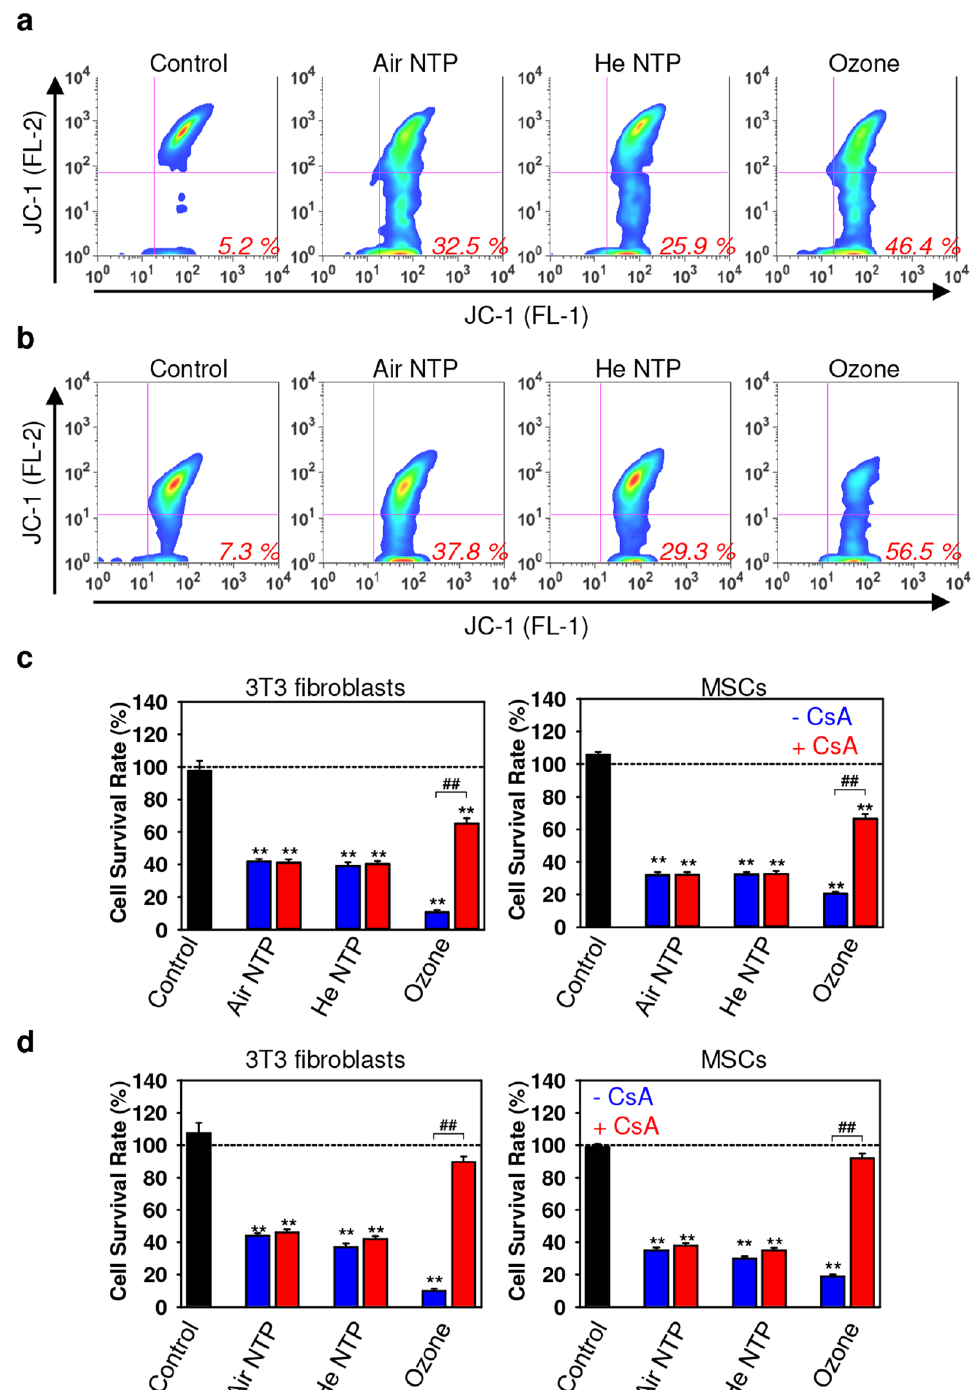
Figure 7. Ozone mediates CypD-related necrosis. Air, helium NTPs and ozone treatments induce mitochondrial dysfunction in 3T3 fibroblasts ( a ) and MSCs ( b ). Cells were stimulated with different NTPs and ozone then stained with 2 μ M JC-1 for 30 min, and analyzed by flow cytometry. Numbers show amounts of JC-1 cells with redlow fluorescence exhibiting damaged mitochondria. Representative flow charts out of three independent experiments are shown. ( c ) Cyclosporin A (CsA, an inhibitor of the mitochondrial permeability transition – mPT) antagonizes the ozone-induced cytotoxicity. Cell viability as detected by the WST-1 assay of 3T3 fibroblasts and MSCs treated with air, helium NTPs or ozone for 60 s with supplementation of 10 µ M CsA, measured 24 h after exposure. Readings were done in quadruplicates, data are present as mean ± SD, n = 4 (four independent experiments), * P < 0.05 ** P < 0.01. ( d ) Appropriate CsA dose completely eliminates ozone-induced cell death. Cell viability as detected by the WST-1 assay of 3T3 fibroblasts and MSCs treated with air, helium NTPs or ozone for 60 s with supplementation of 20 µ M CsA, measured 24 h after exposure. Readings were done in quadruplicates, data are present as mean ± SD, n = 4 (four independent experiments), * P < 0.05 ** P <